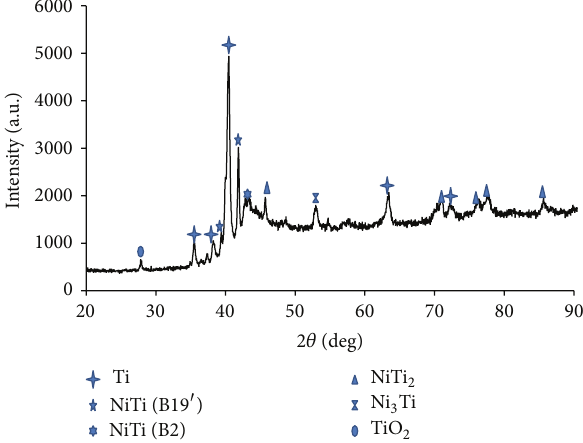
Figure 3: XRD patterns of Ti50Ni50